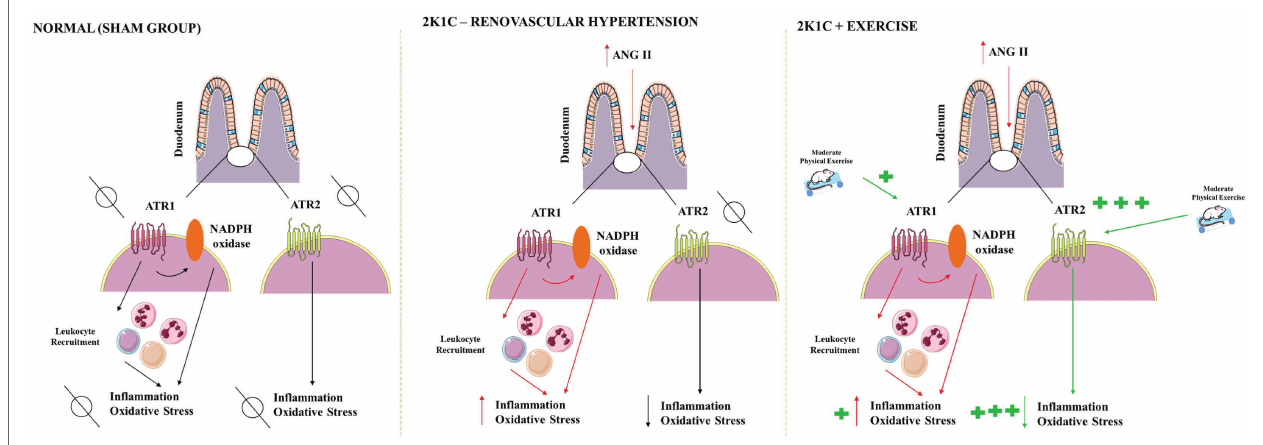
FIGURE 9 | Proposed mechanism of physical exercise actions in renovascular hypertension. After activation of the renin-angiotensin-aldosterone system, the angiotensin II levels are raised in the blood. Angiotensin II acts on G protein-coupled receptors, mainly of the AT1 type; modulates functions in the GI tract; and activates NADPH oxidase which releases reactive oxygen species generating oxidative stress, in addition to promoting inflammation. Hypertension also decreases the CCh responsiveness of duodenum. Moderate physical exercise increases the expression of angiotensin receptors, particularly AT2 type, mediating anti- inflammatory, and antioxidant effects. In rats, 2K1C and submitted to physical exercise was not able to ameliorate the CCh responsiveness of duodenum. AT 1 , angiotensin II receptor type 1; AT 2 , angiotensin II receptor type 2; CCh, carbachol; NADPH, adenine and nicotinamide dinucleotide phosphate. Red arrows indicate hypertension effects. Green arrows indicate physical exercise